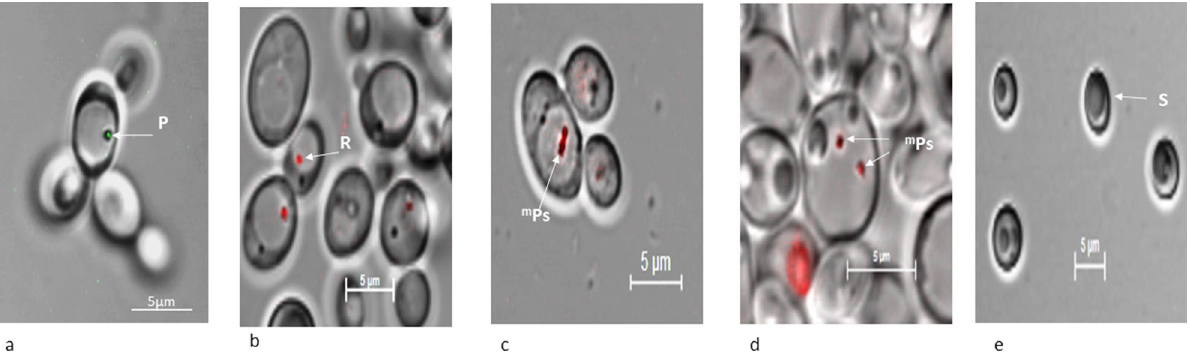
Figure 7. Confocal microscopy images of yeast-bacteria co-cultures under nitrogen deficit showing ( a ) Prochlorococcus sp. as green fluorescent bacteria in C. tropicalis , ( b ) Rhodopseudomonas palustris strain TIE-1 as red fluorescent bacteria in C. tropicalis , ( c , d ) mCherry tagged P. stutzeri as red fluorescent bacteria in C. tropicalis , ( e ) Control C. tropicalis cells grown in nitrogen deficiency without bacteria . Images were magnified with total magnification of 630X with appropriate scale. Arrows indicate: P, Prochlorococcus ; R, Rhodopseudomonas ; m Ps, mCherry Pseudomonas ; S, Spore.